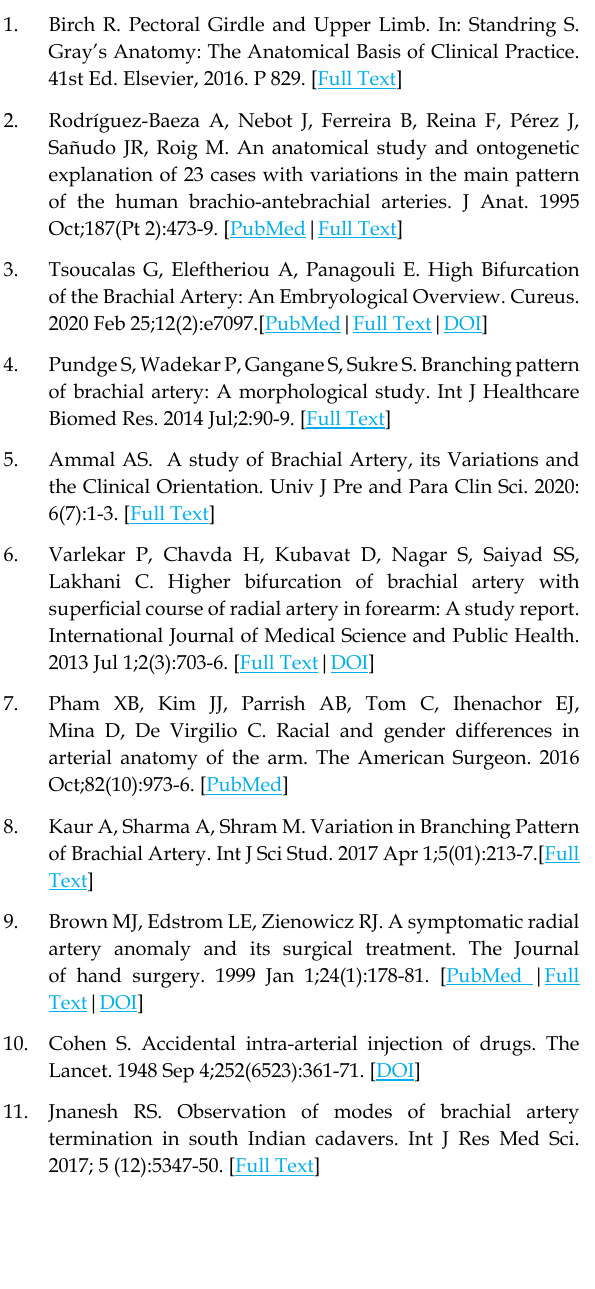
Free Full Text Articles are Available at